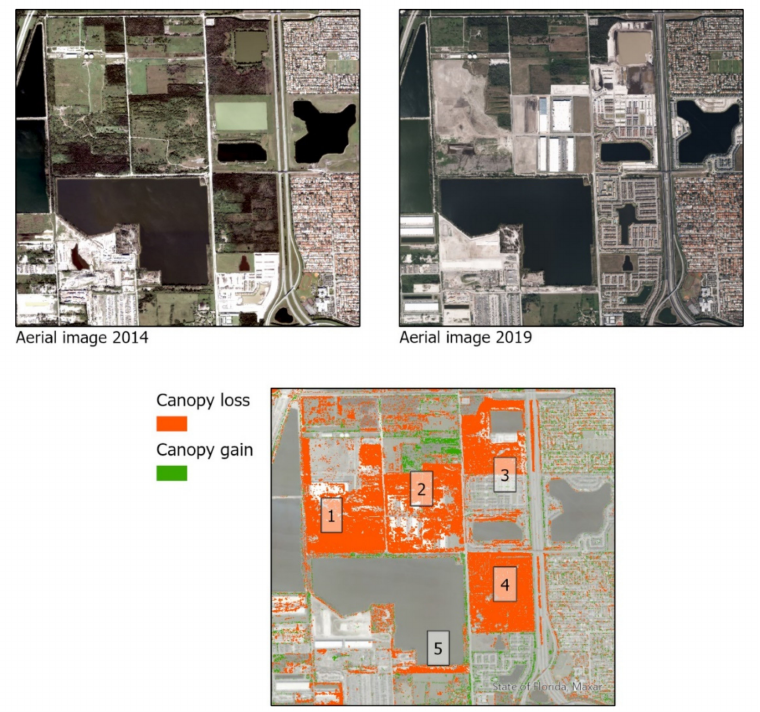
Figure 5. Area of tree canopy loss in Hialeah (municipality and census place) through commercial and residential construction activities (background map credits: State of Florida,